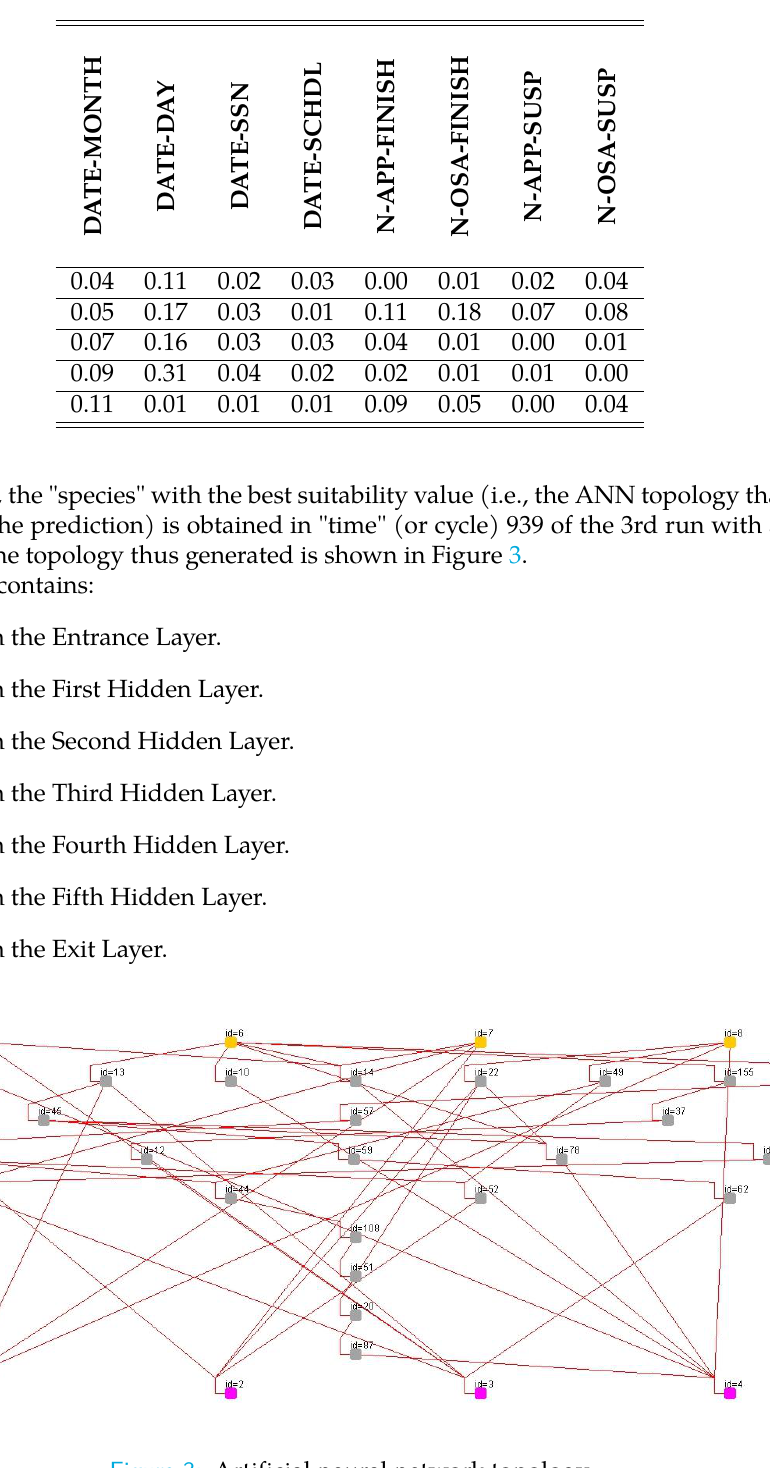
Figure 3: Artificial neural network topology